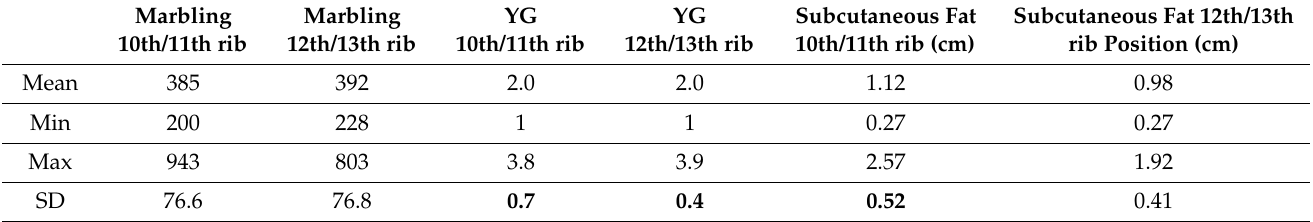
Table 1. Assessed marbling scores and measured carcass traits.